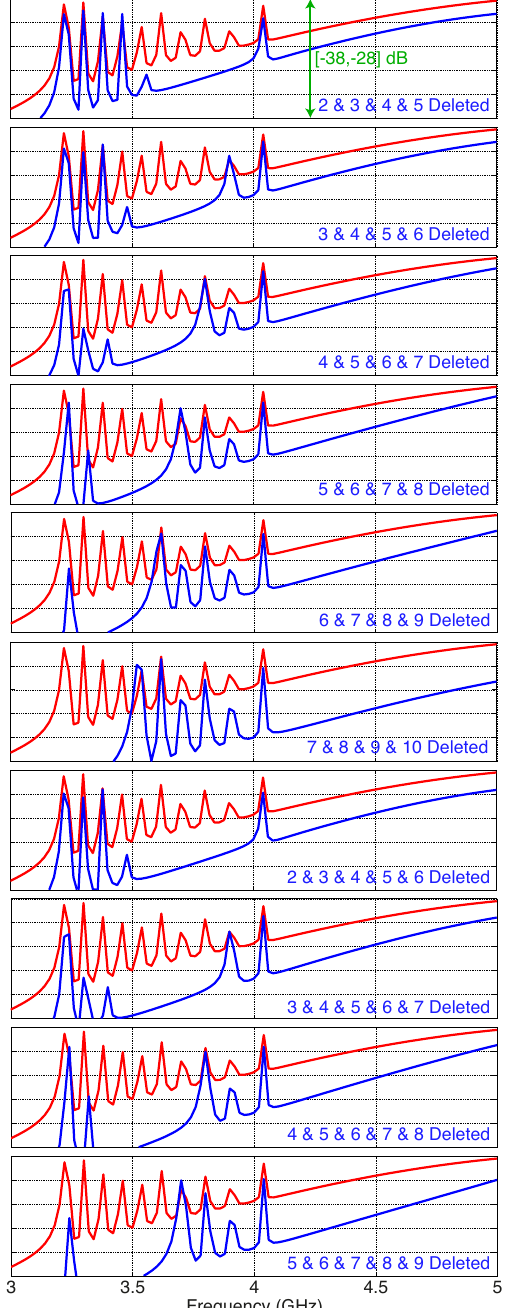
Figure 9: Electromagnetic response of a single resonator when there is thinning on one of the